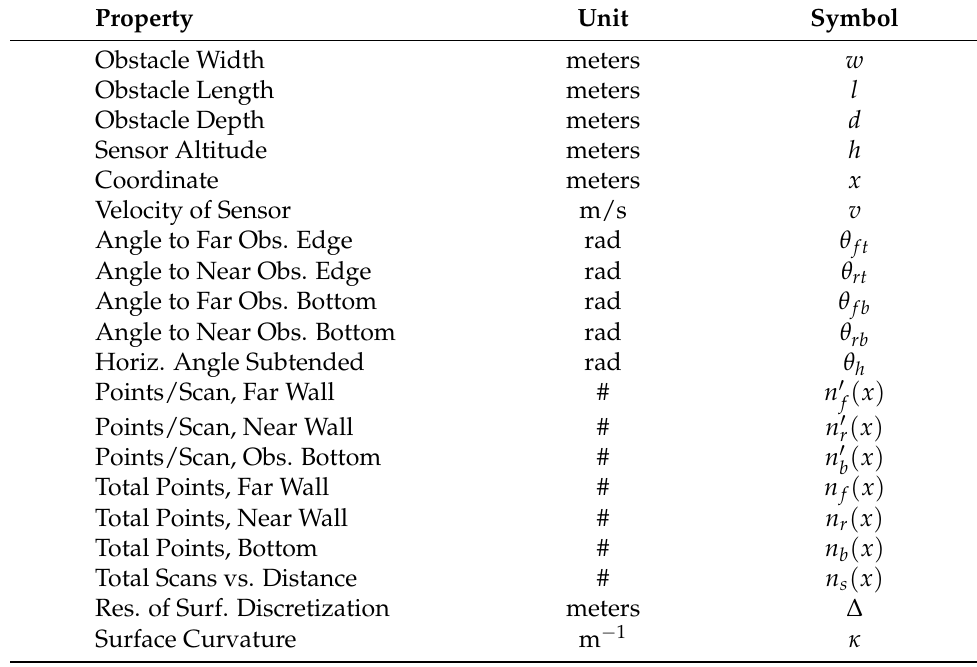
Table 1. Symbols used in this